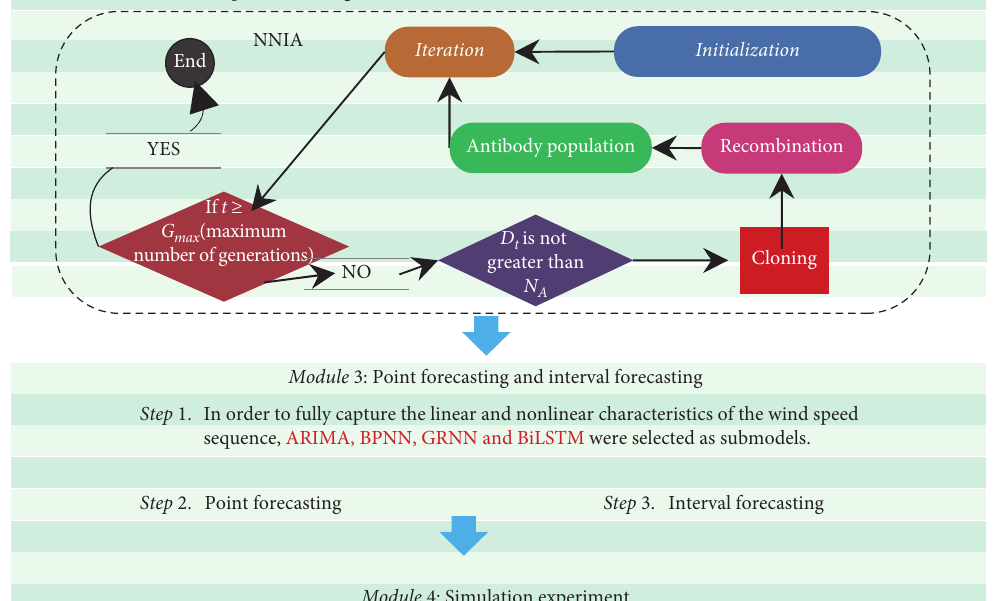
Figure 1: The flowchart of the proposed forecasting system. The proposed model comprises four stages: the first stage is the self-adaption data preprocessing; the second stage is the construction of the contrastive model; the third stage is the construction of the combined system for the interval forecasting and point forecasting; and the fourth stage is the simulation of